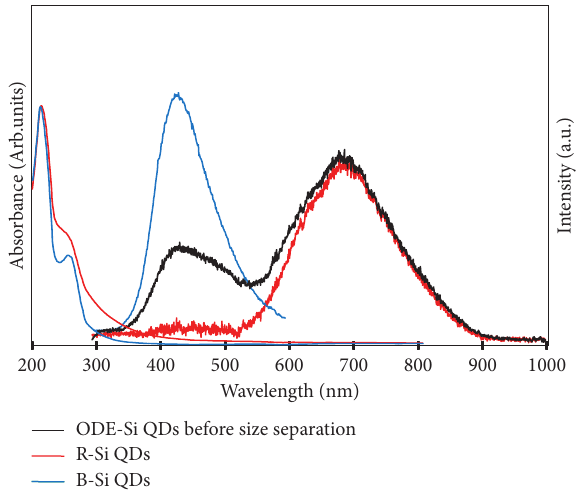
Figure 6: PL emission and UV-vis spectrum of ODE-Si QDs before size separation, R-Si QDs, and B-Si